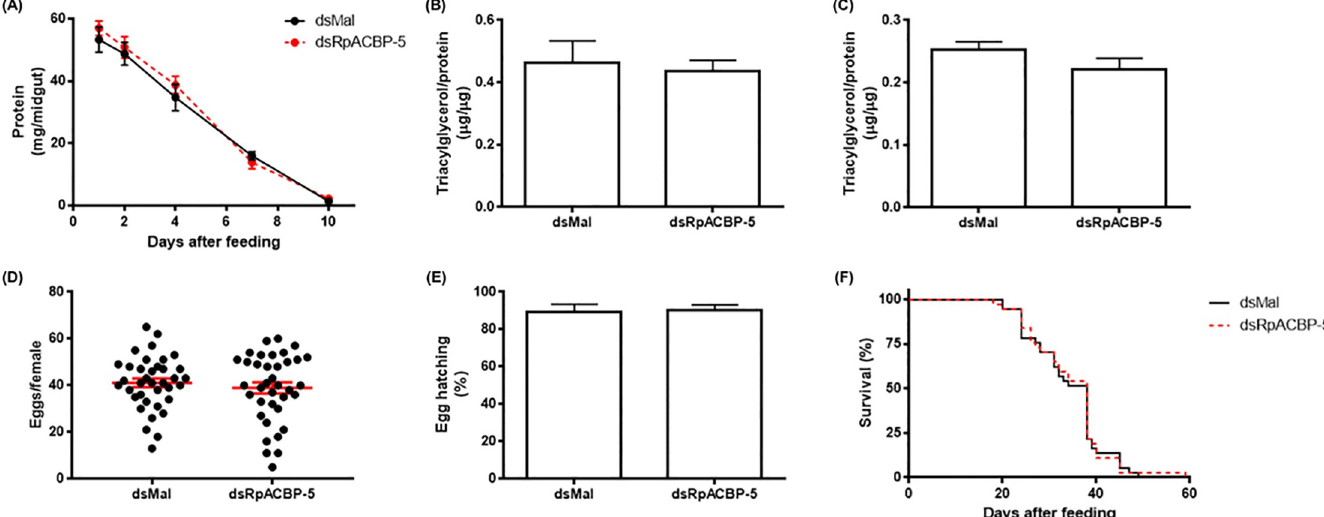
Fig 6. RpACBP-5 knockdown does not affect digestion, lipid accumulation, reproduction or lifespan. Adult fasted females were injected with one μ g of dsRpACBP-5 or dsMal, and insects were fed three days post-injection. The symbols and bars are means ± SEM. (A) Insects were dissected on different days after feeding, and the total protein amount in the midgut was determined. p > 0.05 by two-way ANOVA, n = 9. The fat body (B) and oocytes (C) were collected on the seventh day after feeding, and the TAG content in samples was determined. p > 0.05 by Student’s t -test, n = 8. (D) Oviposition was individually monitored throughout the days after feeding. p > 0.05 by Student’s t -test, n = 37. (E) Eggs were collected on different days of the oviposition cycle. The total number of hatched eggs in each experimental group was determined. p = 0.0776, by χ 2 test, n = 1475. (F) After blood meal, insects were monitored daily. p > 0.05 by Log-Rank test, n = 37.